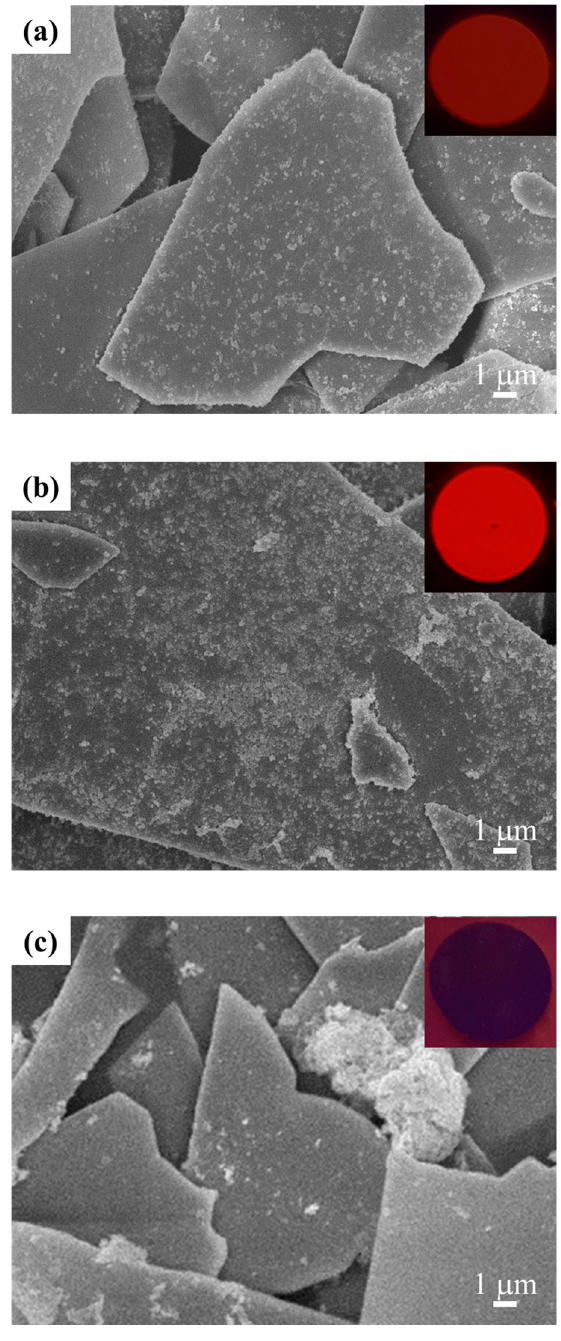
Figure 12. FE-SEM images and inserted fluorescent pictures, of the powders exposed under UV lamp, of Y 2 O 3 :Eu@TMF prepared by the variation in Y 2 O 3 :Eu 3+ loading amount ( a ) 10 wt%, ( b ) 20 wt%, and ( c ) 30 wt% (fixed at pH 8 and 85 o C in H 2